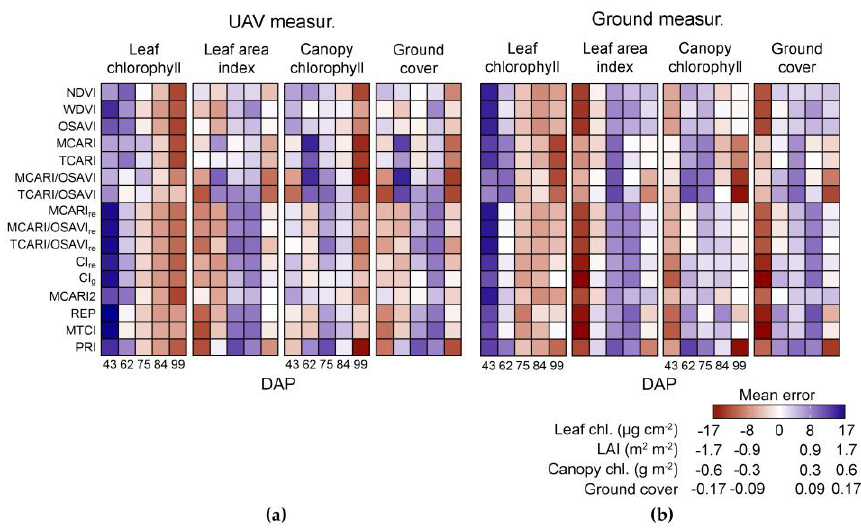
Figure 10. Mean error of linear models relating vegetation indices to crop traits for each acquisition date (from 43 to 99 DAP). Vegetation indices calculated from UAV ( a ) and ground-based measurements ( b